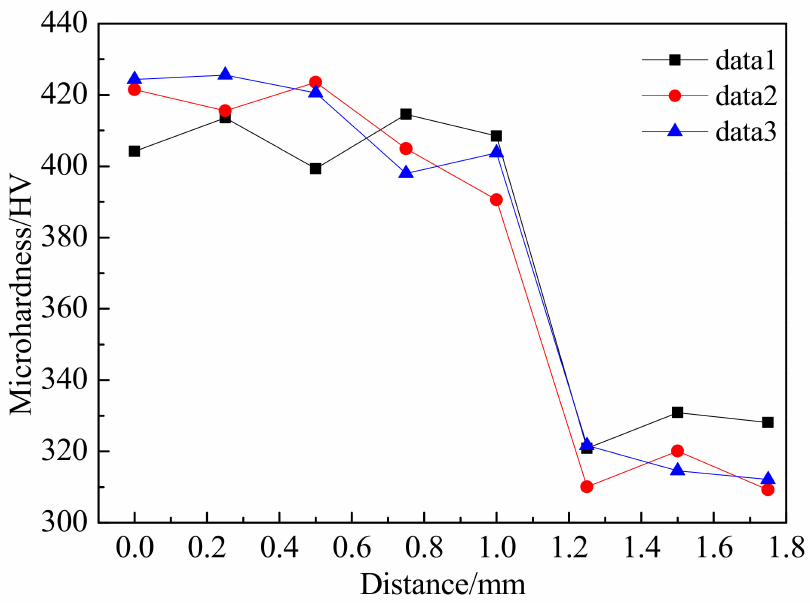
Figure 11. Microhardness curves of the